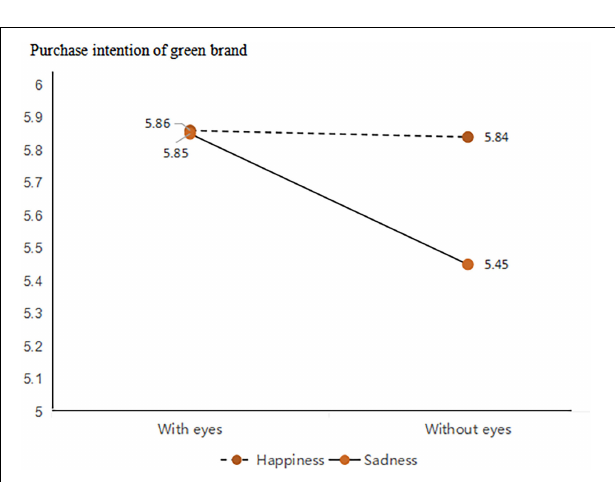
FIGURE 12 | Anthropomorphic strategy of happy expressions without eyes.